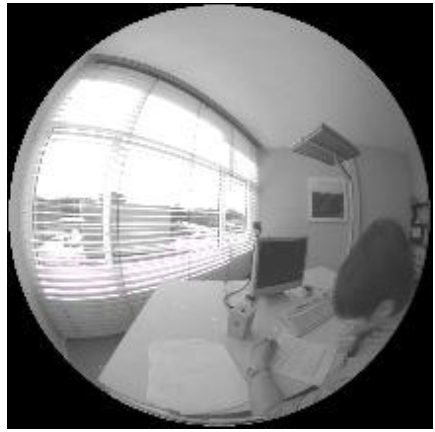
Figure 11. Glare source detection by evalglare factor 7 method for a visual scene of the laboratory study.